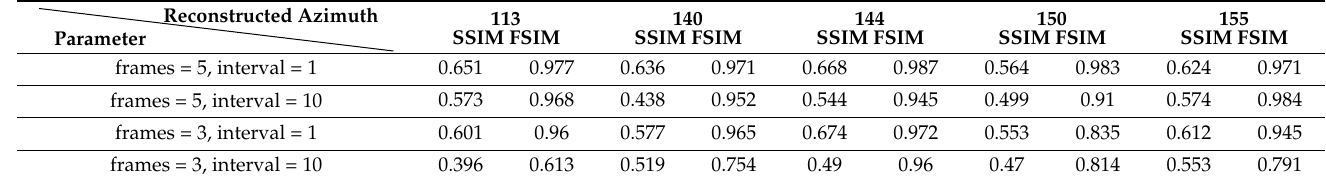
Figure 11. Partial azimuth reconstruction results of T72. Table 1. Similarity calculation of BMP2 reconstruction results.